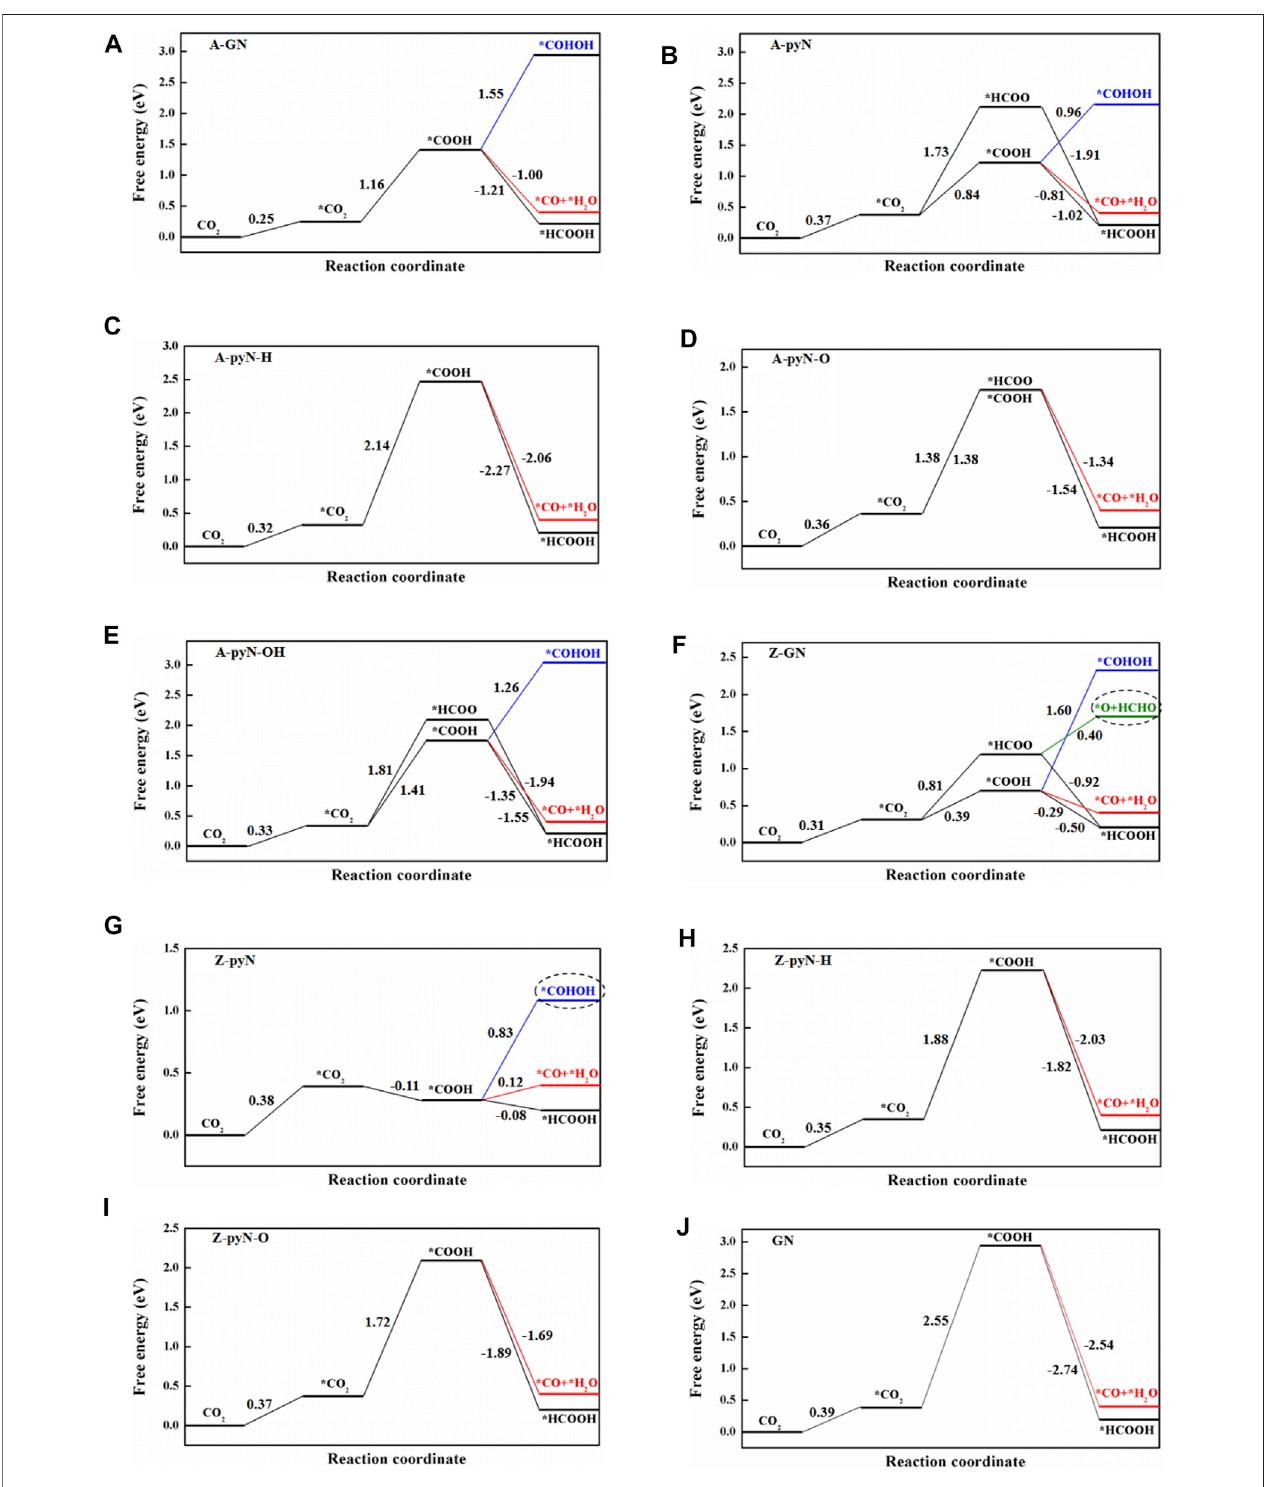
FIGURE 2 | The free energy change for reaction pathways of CO 2 RR on various N-doped graphene. (A) A-GN, (B) A-pyN, (C) A-pyN-H, (D) A-pyN-O, (E) A-pyN- OH, (F) Z-GN, (G) Z-pyN, (H) Z-pyN-H, (I) Z-pyN-O, (J) GN.